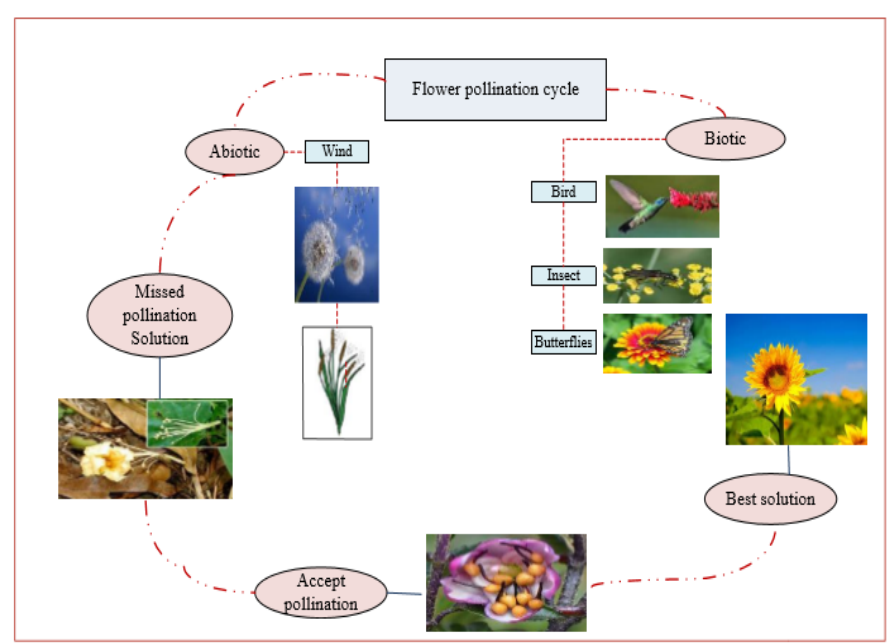
Figure 5. Idea of Flower Pollination Algorithm